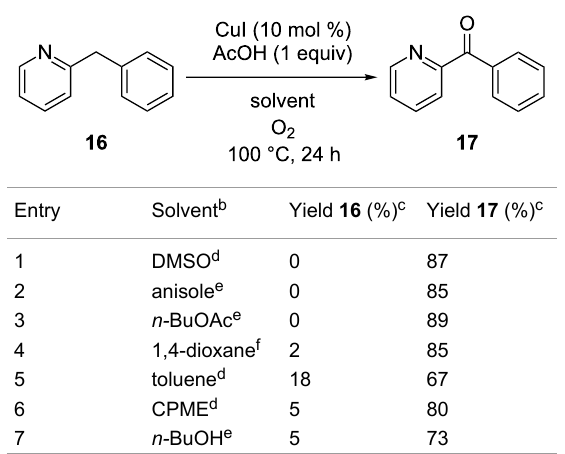
Table 4: An extended solvent screening for the base metal-catalyzed aerobic oxidation reaction. a